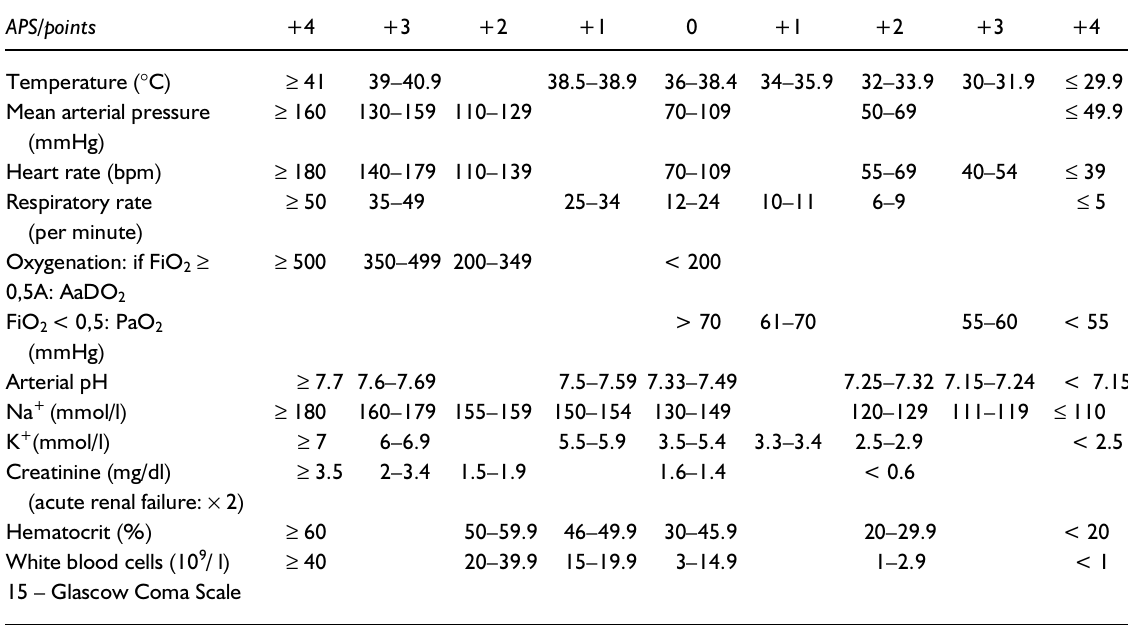
Table 4 The APACHE II is the most commonly used outcome prediction model. Acute Physiology Score (APS), the largest component of the APACHE II score, is derived from 12 clinical measurements that are obtained within 24 hours after admission on the ICU. The most abnormal measurement is selected to generate the APS component